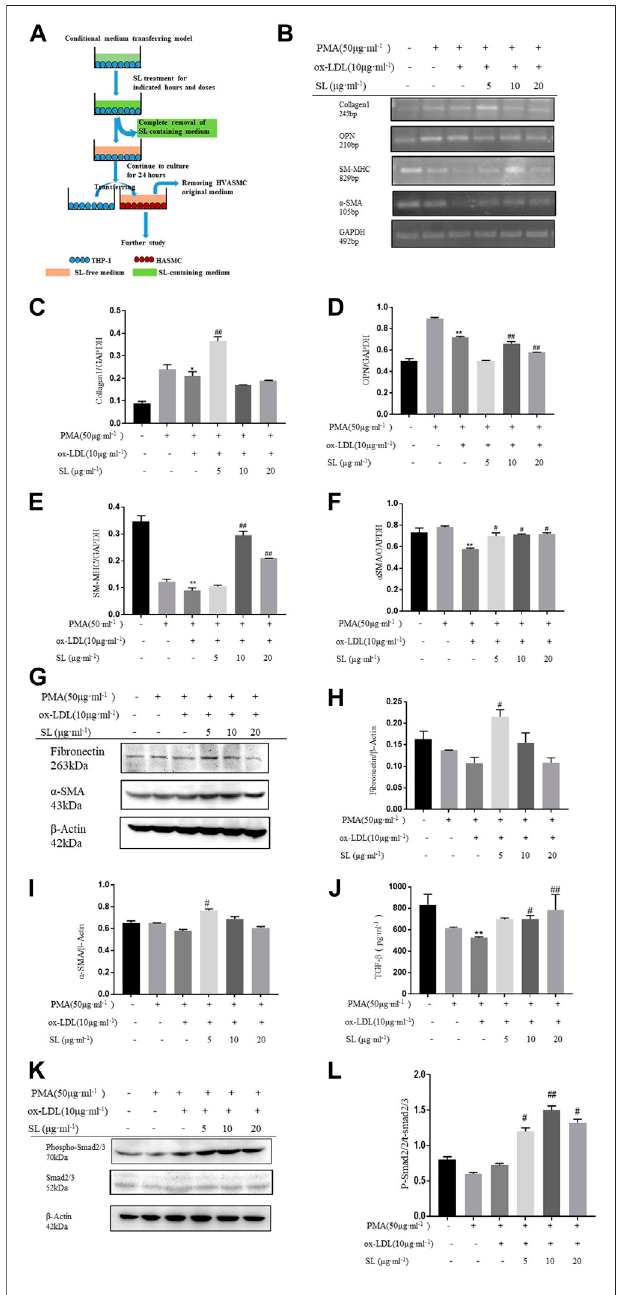
FIGURE 4 | SL increases the SMC contractile phenotype in the macrophage/SMCconditionalmediumtransferringmodel. (A) Invitro ,theprotocol of macrophage/SMC conditional medium transferring model for ef fi cacy identi fi cationofSL. (B-F) RT-PCRassayforECMrelatedmarker(Collagen1), syntheticSMC-relatedmarker(OPN),contractileSMC-relatedmarkers(SM-MHC, α -SMA)inHVASMCsfromthemacrophage/SMCconditionalmediumtransferring model. (G-I) Detection of the protein expression of fi bronectin, α -SMA, and GAPDH treated with SL in HVASMCs from the macrophage/SMC conditional mediumtransferringmodel. (J) TGF- β levelsdetectedbyELISAinthesupernatant ofthemacrophage/SMCconditionalmediumtransferringmodel. (K,L) p-Smad2/ 3normalizedbySmad2/3levelinwesternblottingassay.* p < 0.05and** p < 0.01 compared with theuntreatedgroup, and# p < 0.05and## p < 0.01comparedto control groups treated with ox-LDL, n (cid:2)